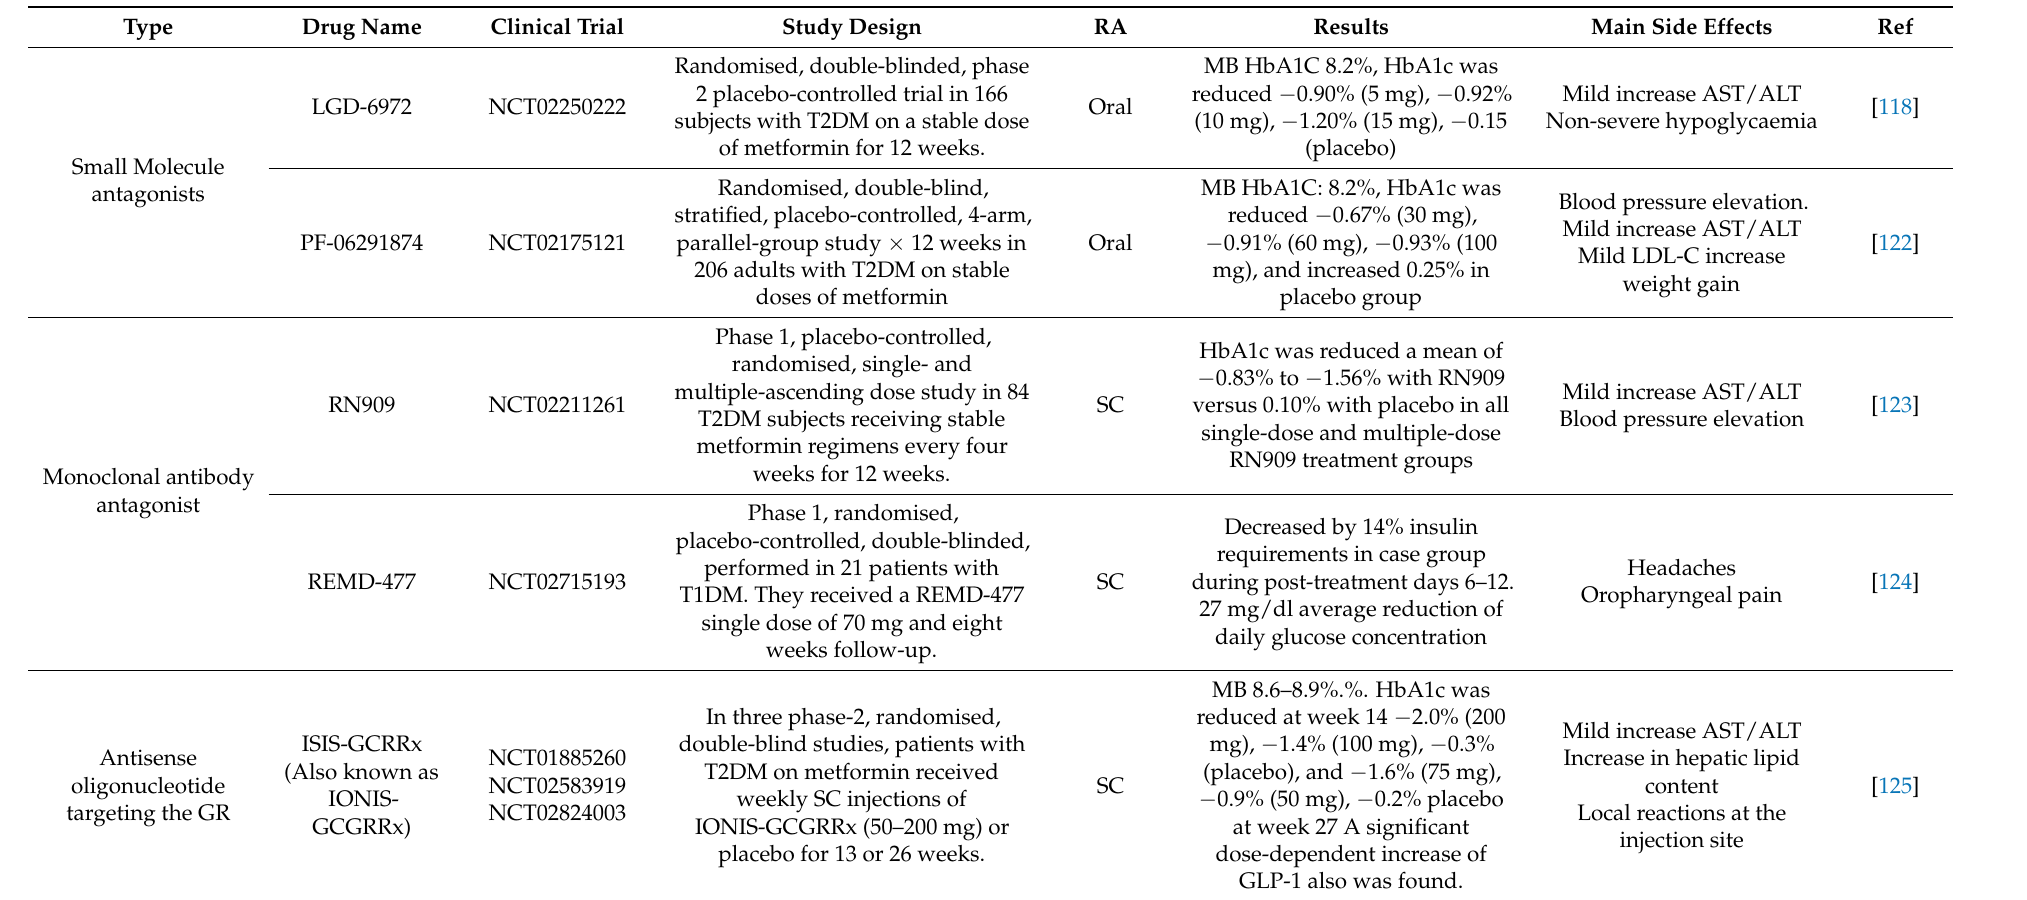
Table 1. Current glucagon receptor antagonist experimental